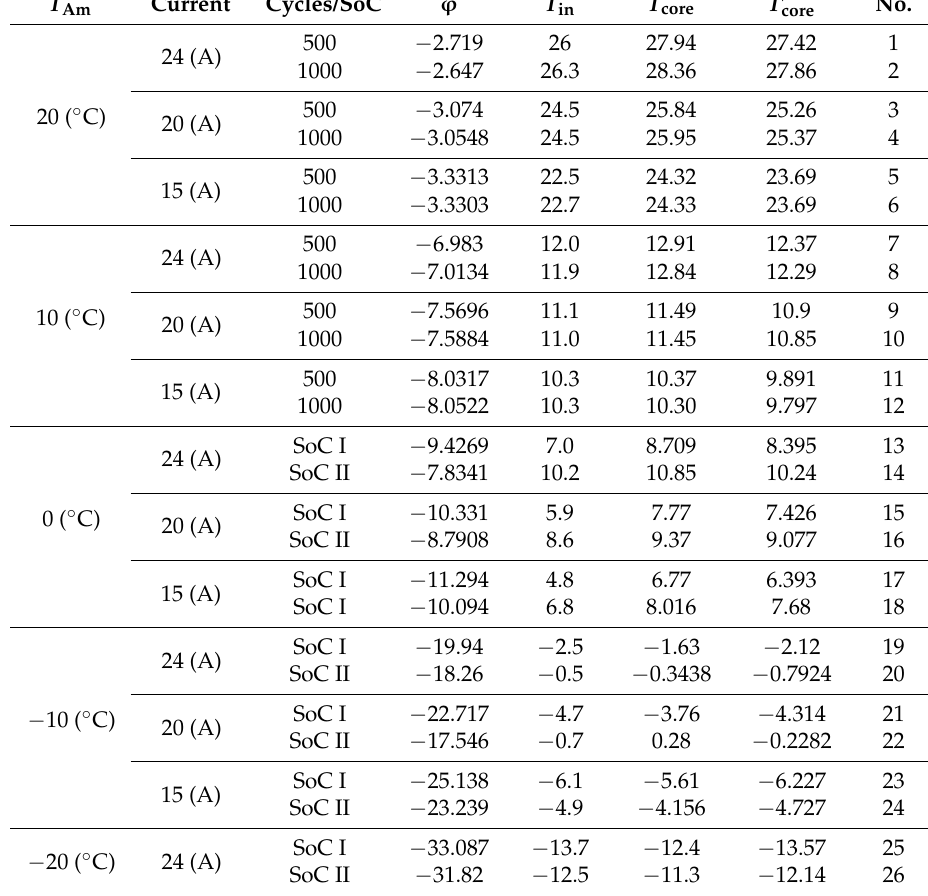
Table 7. The verification of the temperature estimator considering the relaxation time. T